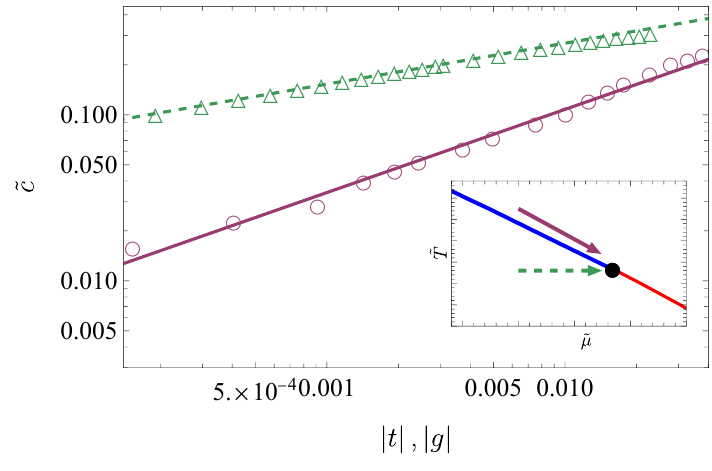
Figure 4 . The critical behaviors of the chiral condensate for the two different paths to the TCP in log scale. Inset shows the phase diagram for h = 0 and the two arrows denote the two different paths. One path is along the triple line, which is asymptotically tangential to the phase boundary (purple solid arrow). The other is the path with t = 0 (green dashed arrow). The open circles and triangles denote the numerical plots for each path, respectively, and the purple solid and green dashed lines show the fitting results.